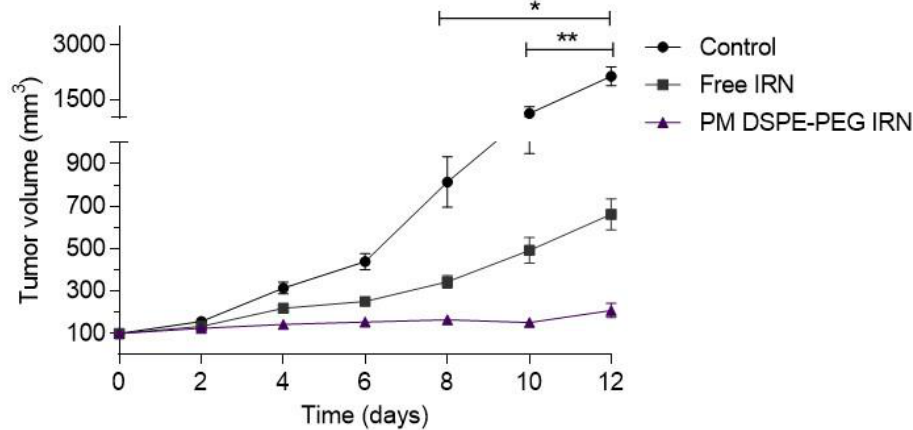
Figure 5. Tumor volume as a function of time after intravenous administration of saline solution (control), free IRN (IRN solution), micellar preparation IRN-loaded (PM DSPE-PEG IRN) in CT26 tumor-bearing BALB/c mice. Note: * represents a significant difference between IRN-loaded micellar treatment groups compared with the control group. ** represents a significant difference between treatments with IRN-loaded micellar formulation compared with the free IRN group ( p < 0.05).